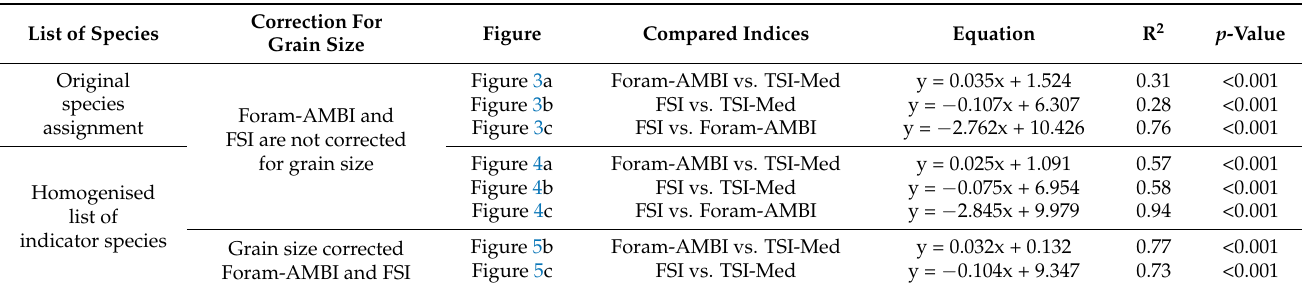
Table 4. Summarised information on the simple linear regressions between the indices based on group of indicator species (Foram-AMBI, TSI-Med, and FSI).